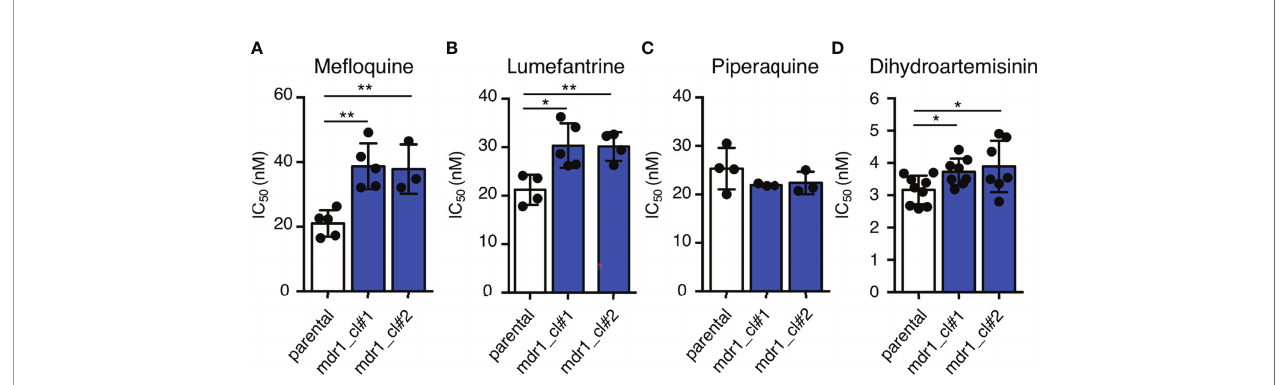
FIGURE 3 | An additional copy of mdr1 modi fi ed susceptibility to multiple antimalarial drugs. (A – D) The IC 50 values were determined for the antimalarial drugs me fl oquine, lumefantrine, piperaquine, and dihydroartemisinin with pfcas9-mdr1 parasites (mdr1_cl#1 and mdr1_cl#2) and the pfcas9 parental strain (parental). IC 50 values of me fl oquine (A) , lumefantrine (B) , and dihydroartemisinin (D) with transgenic parasites were higher than those of the parental strain, but the IC 50 values of piperaquine (C) were not signi fi cantly different. Mean ± SEM IC 50 values ( Table 1 ) were calculated three to nine times. Statistical evaluations comparing the transgenic parasites and parental strain were performed using Student ’ s t-tests. *p < 0.05; **p < 0.01.